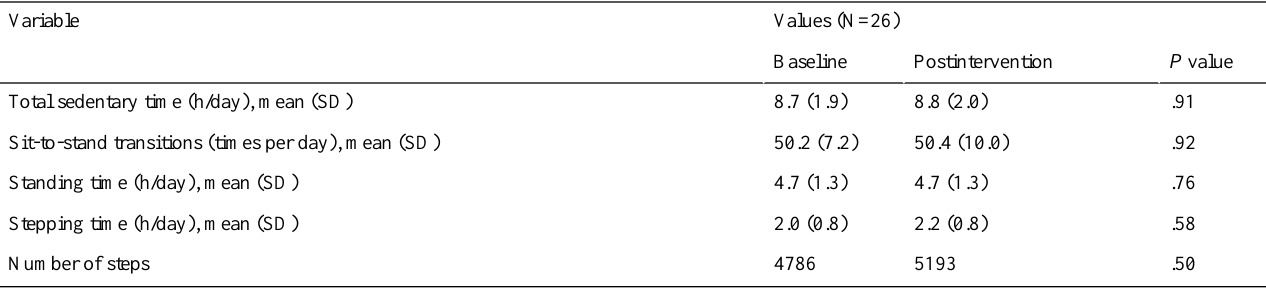
Table 2. Preliminary efficacy of the